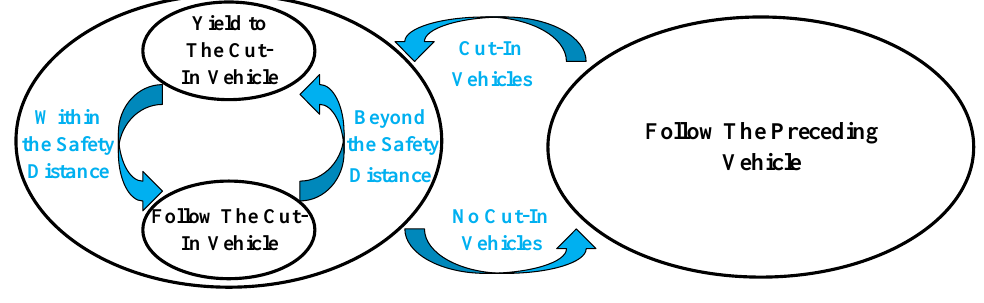
Figure 2. The FSM of the host vehicle.